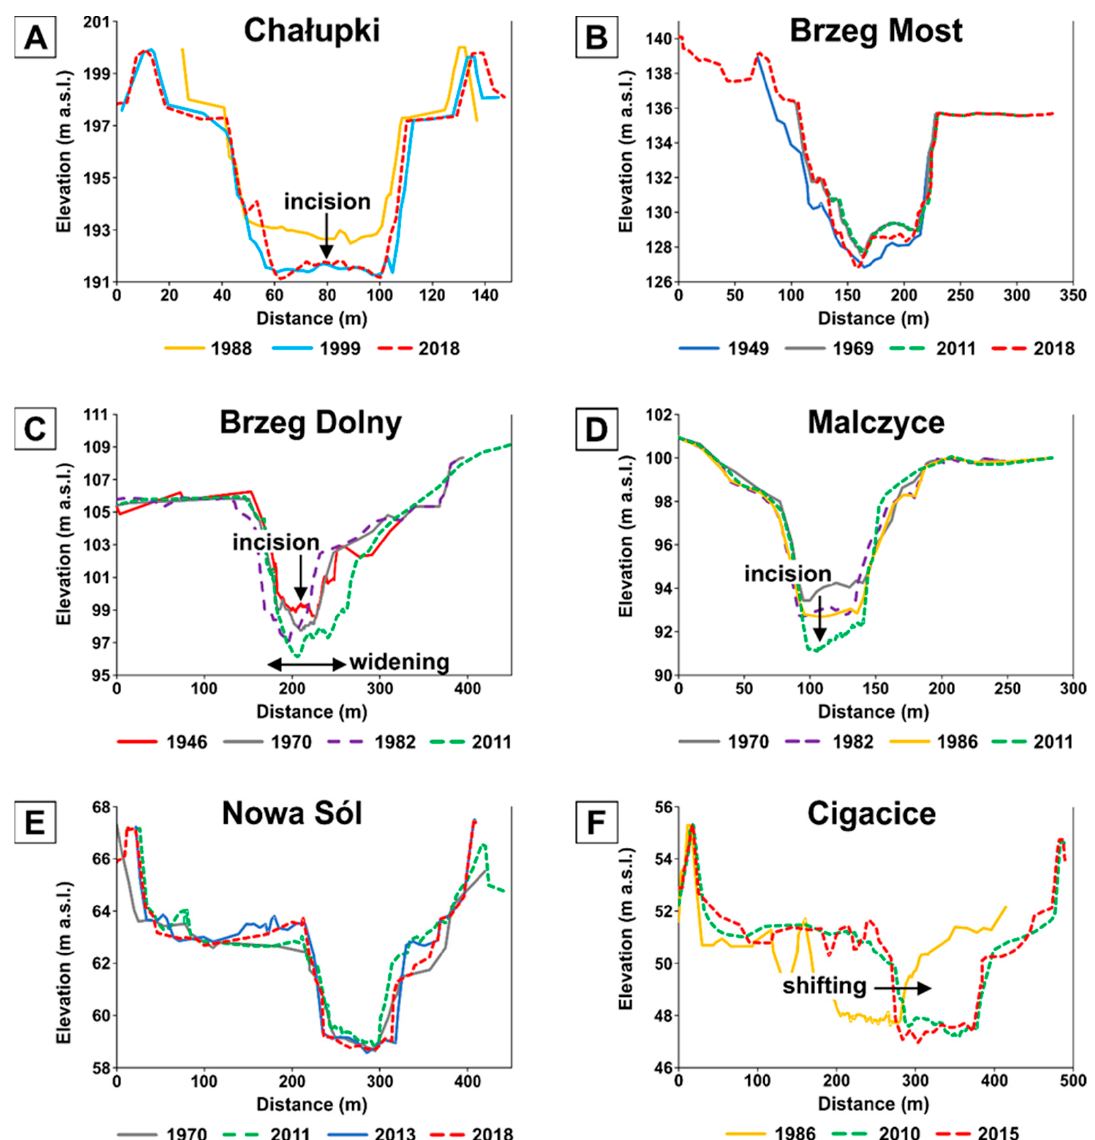
Figure 7. Examples of changes in the gauge cross sections of the Odra River from the studied river sections ( A–F ) based on surveys in the years 1946–2018.